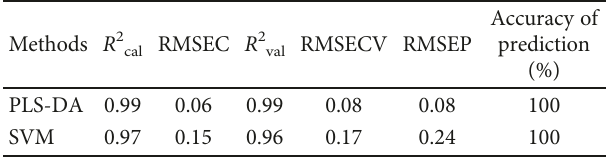
Figure 8: SVM method model plot of predicted values and obtained reference values. Table 3: The features of the two models built by the PLS-DA and SVM